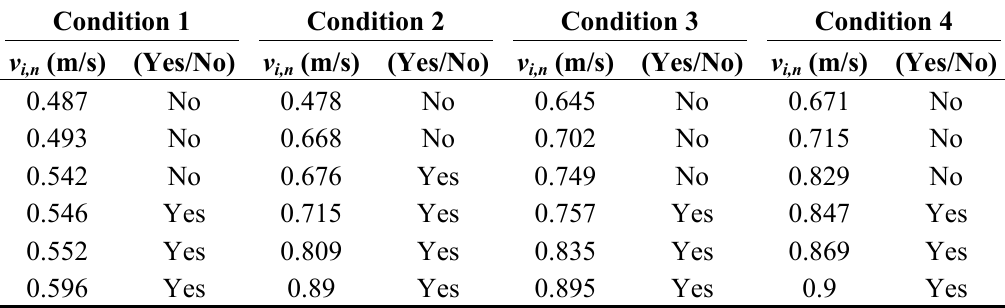
Table 3. The variation of the critical velocity under different conditions. Condition 1 Condition 2 Condition